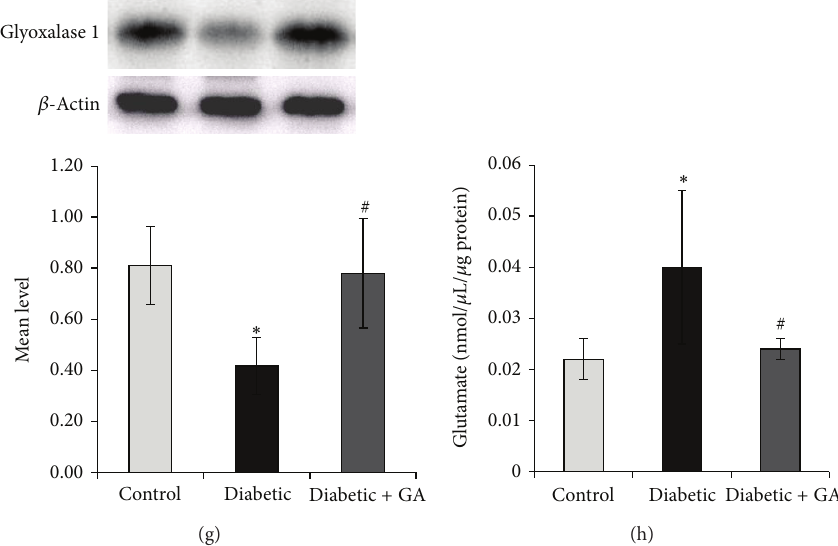
Figure 1: Western blot analysis of high-mobility group box-1 (HMGB1), extracellular signal-regulated kinase 1 and 2 (ERK1/2), cleaved caspase-3, synaptophysin, tyrosine hydroxylase, glutamine synthetase, and glyoxalase 1 in rat retinas. 𝛽 -Actin was used as a housekeeping control. Protein expression of ERK1/2 activation (phosphorylation) was quantified by Western blot analysis using phospho- (P-) ERK1/2 specific antibody and was adjusted to the protein levels of unphosphorylated ERK1/2 antibody in each sample. There is a significant increase in the expression of HMGB1 (a), activated ERK1/2 (b), and cleaved caspase-3 (c) and a significant decrease in the expression of synaptophysin (d), tyrosine hydroxylase (e), glutamine synthetase (f), and glyoxalase 1 (g) in the retinas of diabetic rats compared to nondiabetic controls. Glycyrrhizic acid (GA) significantly attenuated diabetes-induced upregulation of HMGB1 (a), activated ERK1/2 (b), and cleaved caspase-3 (c) and diabetes-induced downregulation of synaptophysin (d), tyrosine hydroxylase (e), GS (f), and glyoxalase 1 (g). Glutamate assay revealed a significant increase in glutamate levels in the retinas of diabetic rats compared to nondiabetic controls. The levels of glutamate in the GA- treated diabetic rats were significantly less than those in the untreated diabetic rats (h). Each experiment was repeated at least 3 times with fresh samples. A representative set of samples is shown. Results are expressed as mean ± SD of at least 6 rats in each group. ∗ 𝑃 < 0.05 compared with nondiabetic control rats. # 𝑃 < 0.05 compared with diabetic